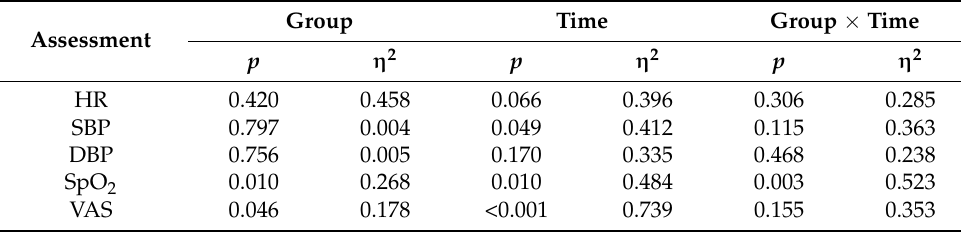
Table 4. Effects of music on vital signs and visual analogue scale for pain.